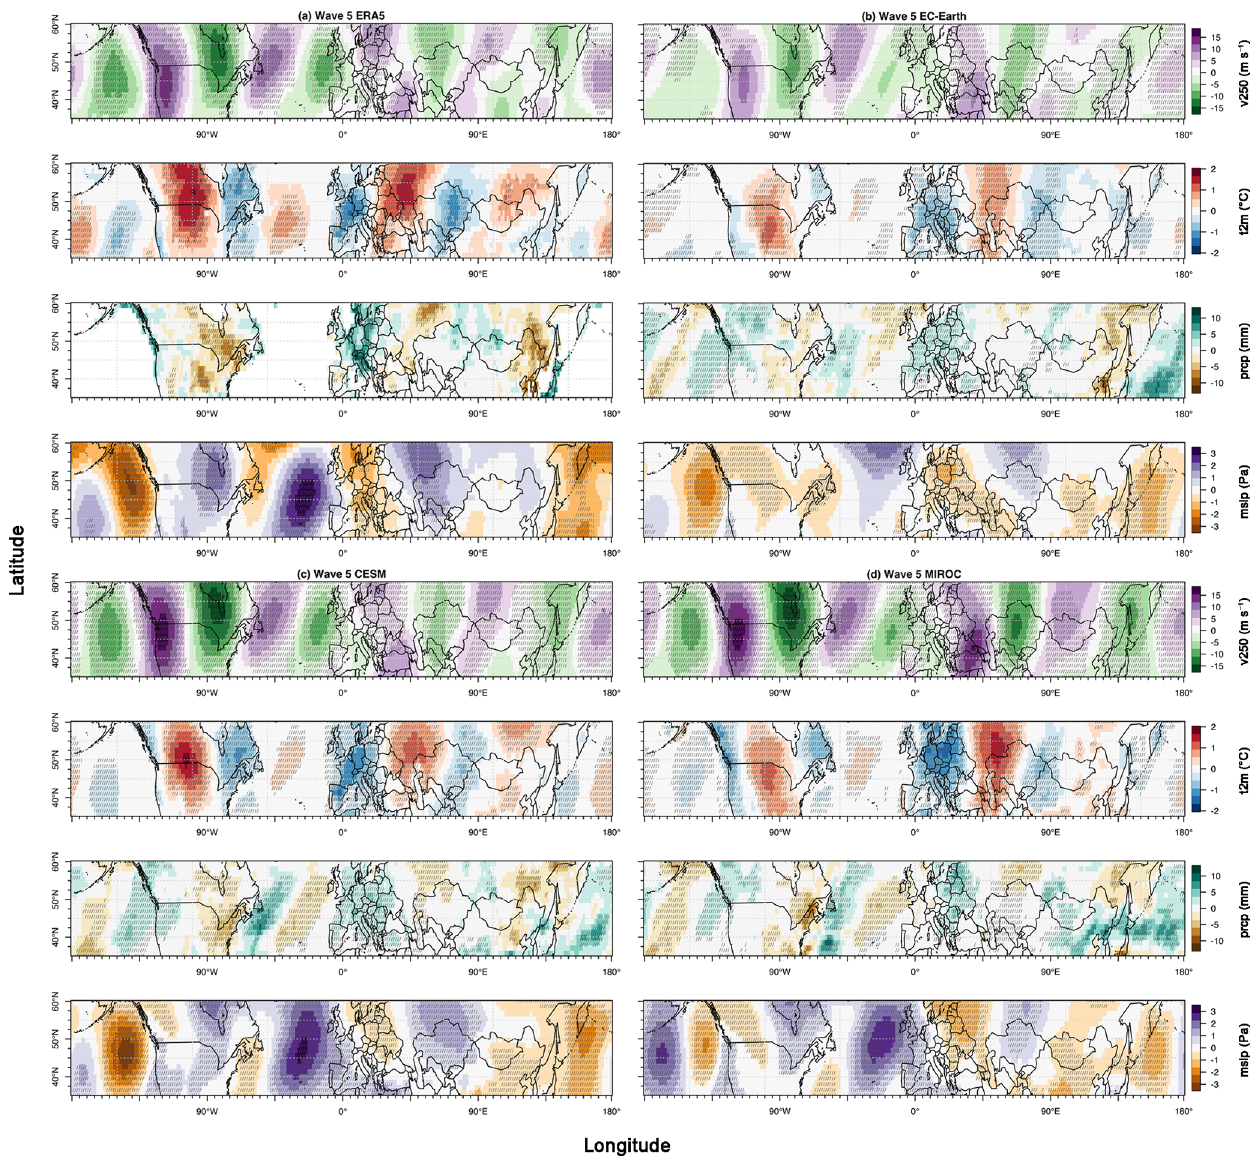
Figure B12. Same as Fig. 3 but with significance test at 95% confidence level applied. Values significantly exceeding the 95% confidence level from composites between amplified and non-amplified periods are